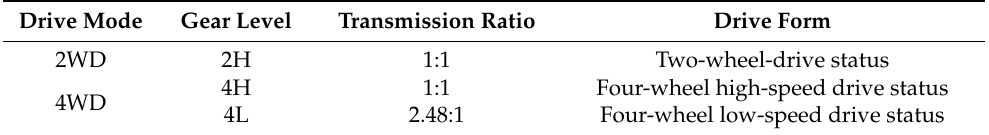
Table 1. Transmission ratios for different drive modes and drive states.